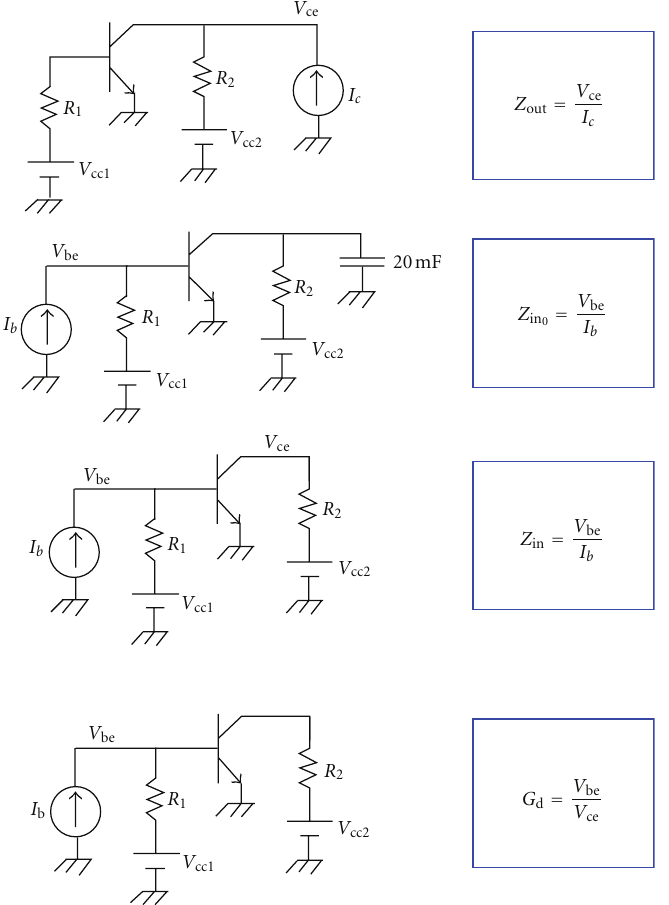
Figure 2: Measurements used to determine the h 21